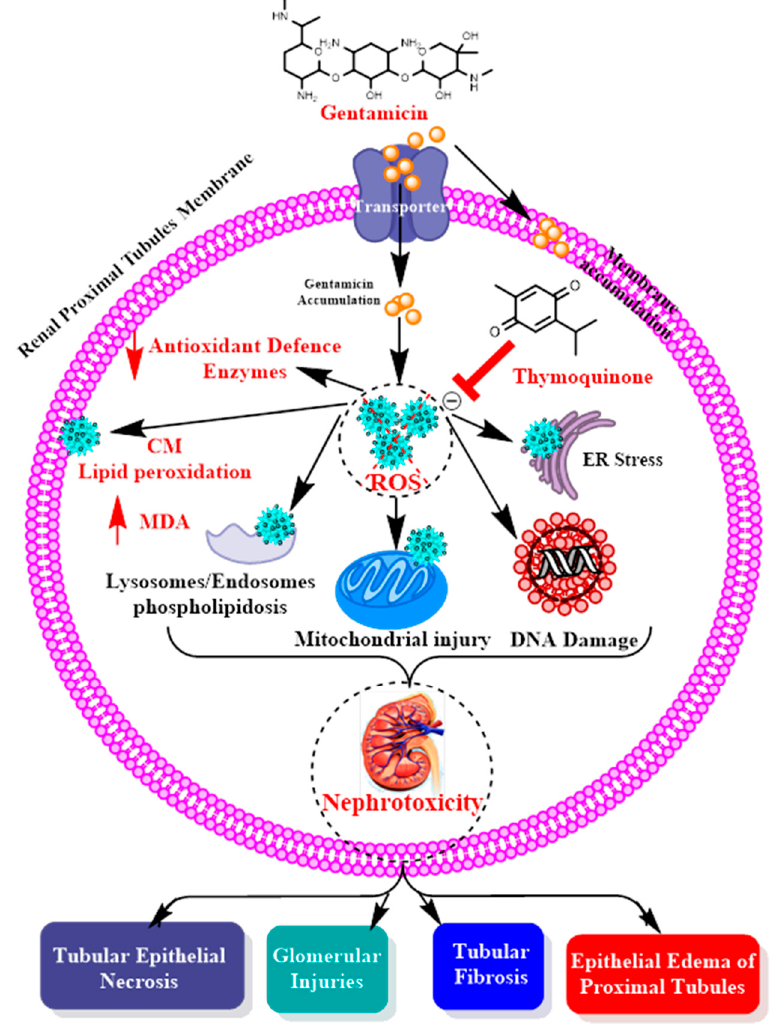
Figure 3. Gentamicin induction of nephrotoxicity by ROS pathway. TQ protects the proximal tubules by acting as a scavenger of ROS and preventing nephrotoxicity.